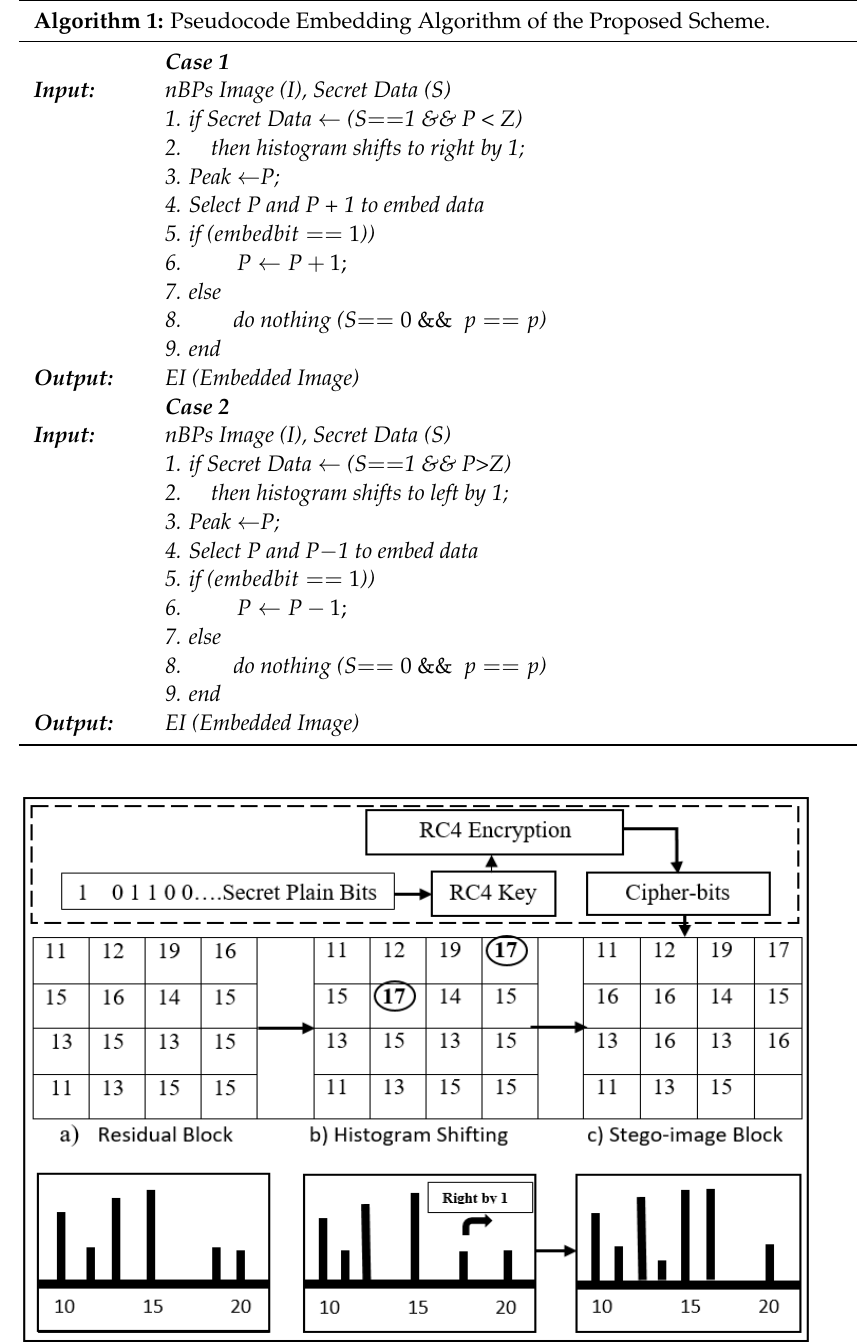
Figure 5. Histogram shifting illustration .